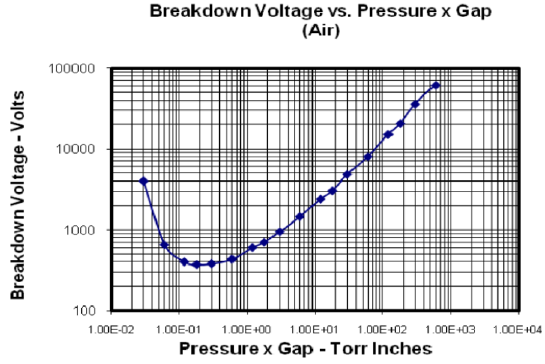
Fig. 15 Paschen’s curve for air